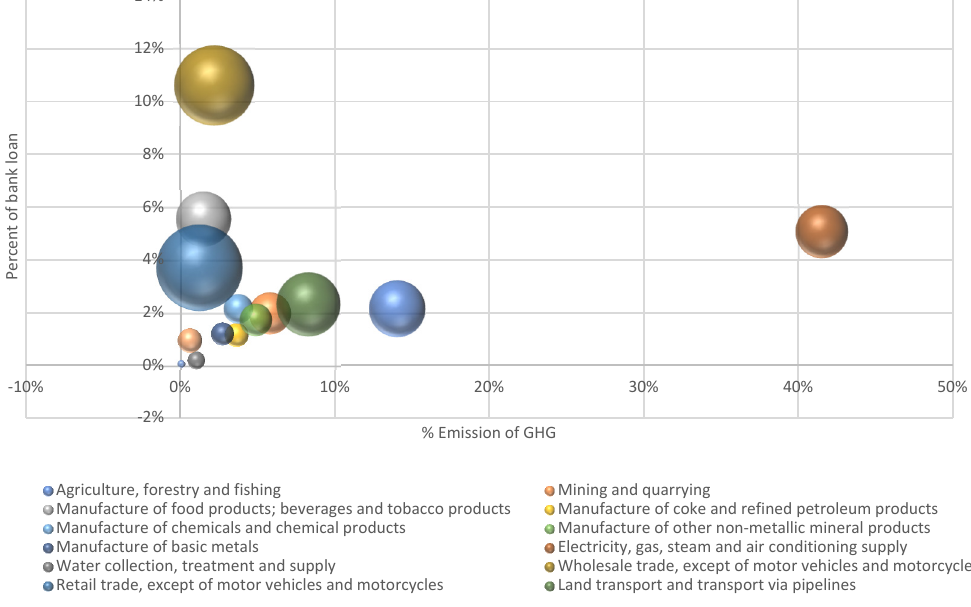
Figure 7. Bank loans and GVA of Poland’s emission-intensive economic sectors.